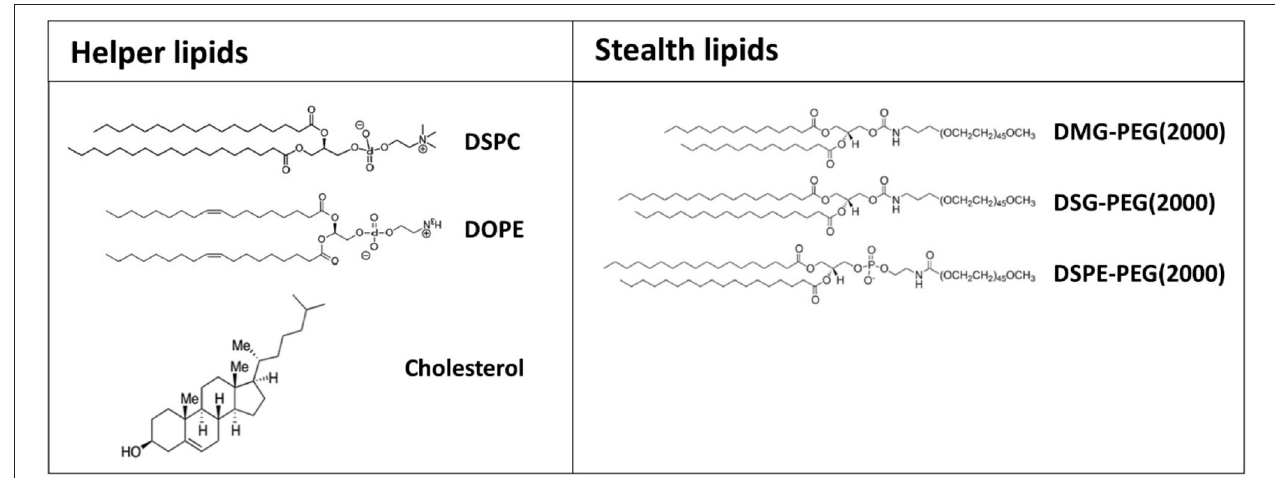
FIGURE 4 | Chemical structure of the most common helper and stealth lipids employed for the preparation of formulated mRNA.